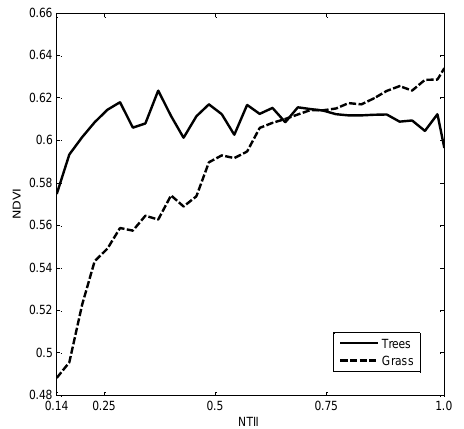
Figure 5. Mean NDVI vs. NTII for ‘Grass healthy’ and ‘Trees’